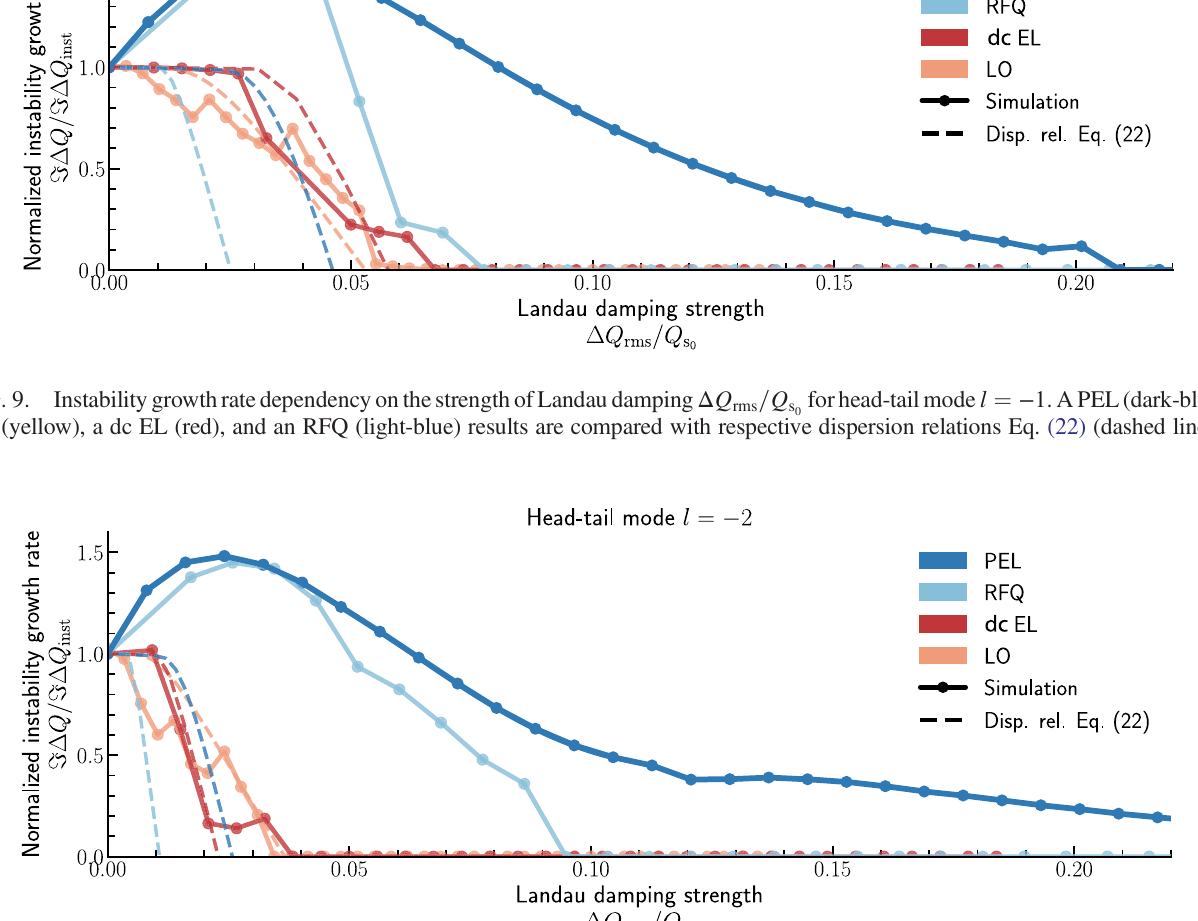
FIG. 10. Instability growth rate dependency on the strength of Landau damping Δ Q blue), LO (yellow), a dc EL (red), and an RFQ (light-blue) results are compared with respective dispersion relations Eq. (22) (dashed